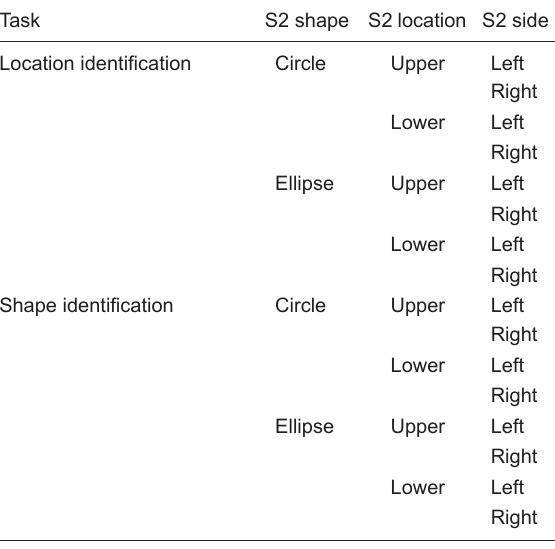
Table 1. Representation of the eight experimental conditions tested with the group of participants who performed the location identification task and the group of participants who performed the shape identification